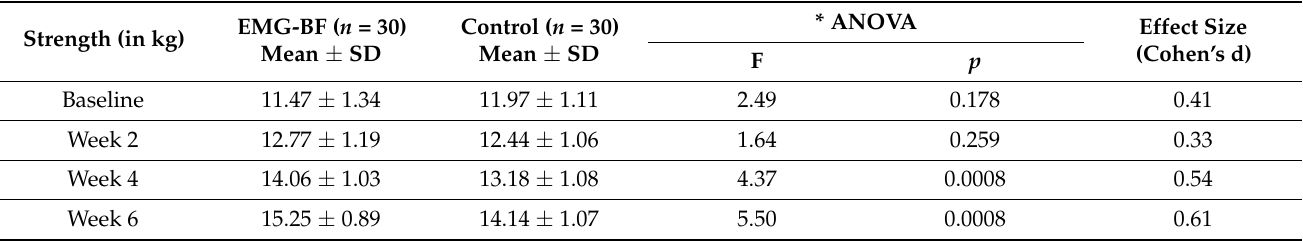
Table 3. Comparison of quadriceps strength between two